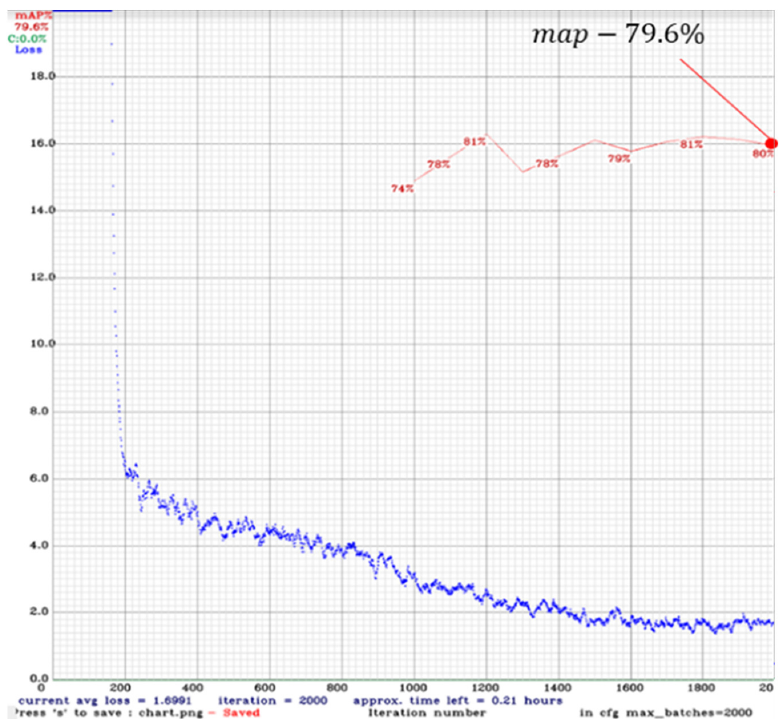
Figure 9. YOLOv4 tiny training gragh.